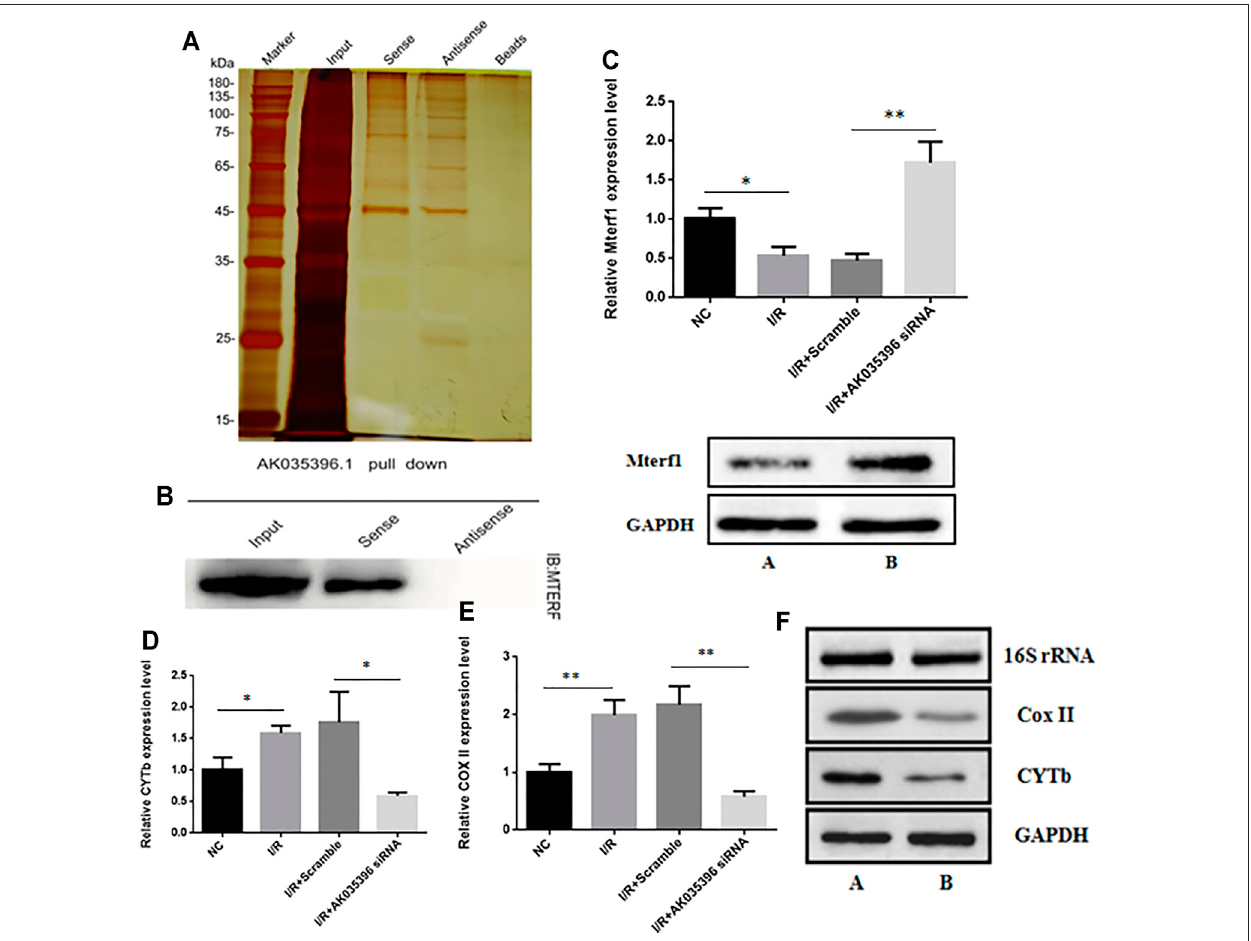
FIGURE 4 | The effect of AK035396 on the expression of mitochondrial genes and target genes. Mice and primary cardiomyocytes were used to establish I/R models. (A – B) RNApull-downandWesternblotanalysesshowingthatAK035396bindstoMterf1. (C) TheexpressionlevelofMterf1intheNC,I/R,I/R+ScrambleandI/ R + AK035396 siRNA groups were determined by qRT-PCR (up) and the expression of Mterf1 in the I/R group [AK035396+/+ (A) and AK035396 − / − (B) ] were determined by Western blotting (down) . (D – E) Expression levels of CoxII and CYTb in the NC, I/R, I/R + Scramble and I/R + AK035396 siRNA groups. (F) The expression of CoxII and CYTb in the I/R group [AK035396+/+ (A) and AK035396 − / − (B) ] was determined by Western blotting.